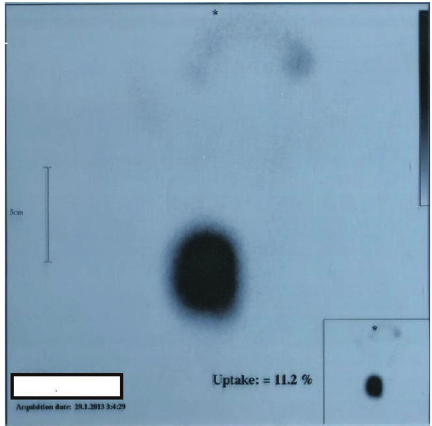
Figure 1: Technetium thyroid scan showing autonomous (hot) nodule, with suppression of uptake in the surrounding tissue.